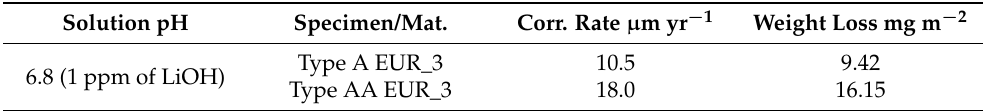
Table 4. Corrosion rates measurements for 1000 h exposure at 300 °C, 155 bar, and 2 ms − 1 for EUROFER